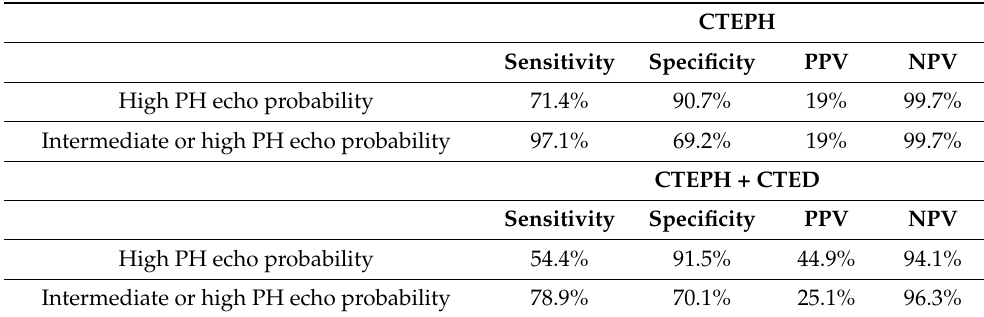
Table 4. Diagnostic value of echocardiographic probability of pulmonary embolism in the diagnosis of CTEPH and diagnosis of CTEPH and CTED